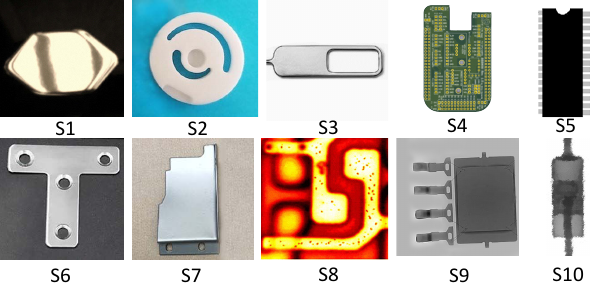
Figure 6. The source shapes in the test dataset, numbered from S1 to S10 .